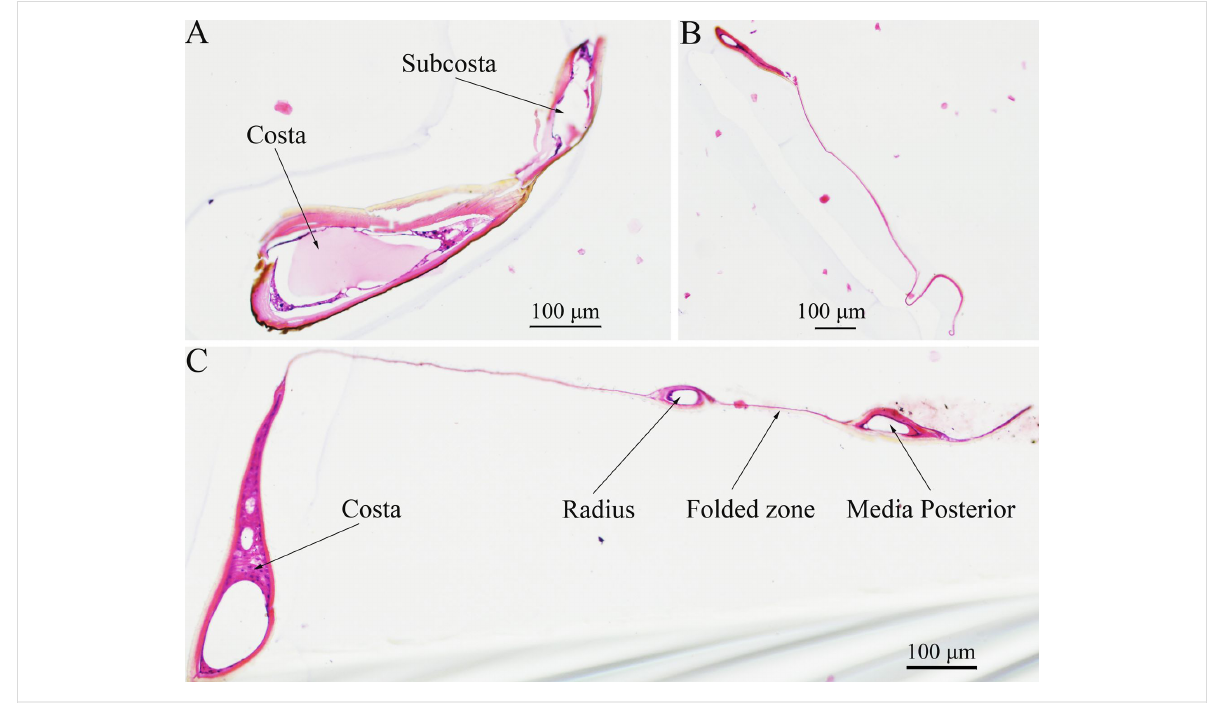
Figure 3: The cross sections of (A) the wing base (C-S1), (B) the posterior part of the wing (C-S2) and (C) the folded zone of the costa (C-S3) of C. japonicus (10 ×), obtained using an inverted fluorescence microscope. The vein cavity is irregular.